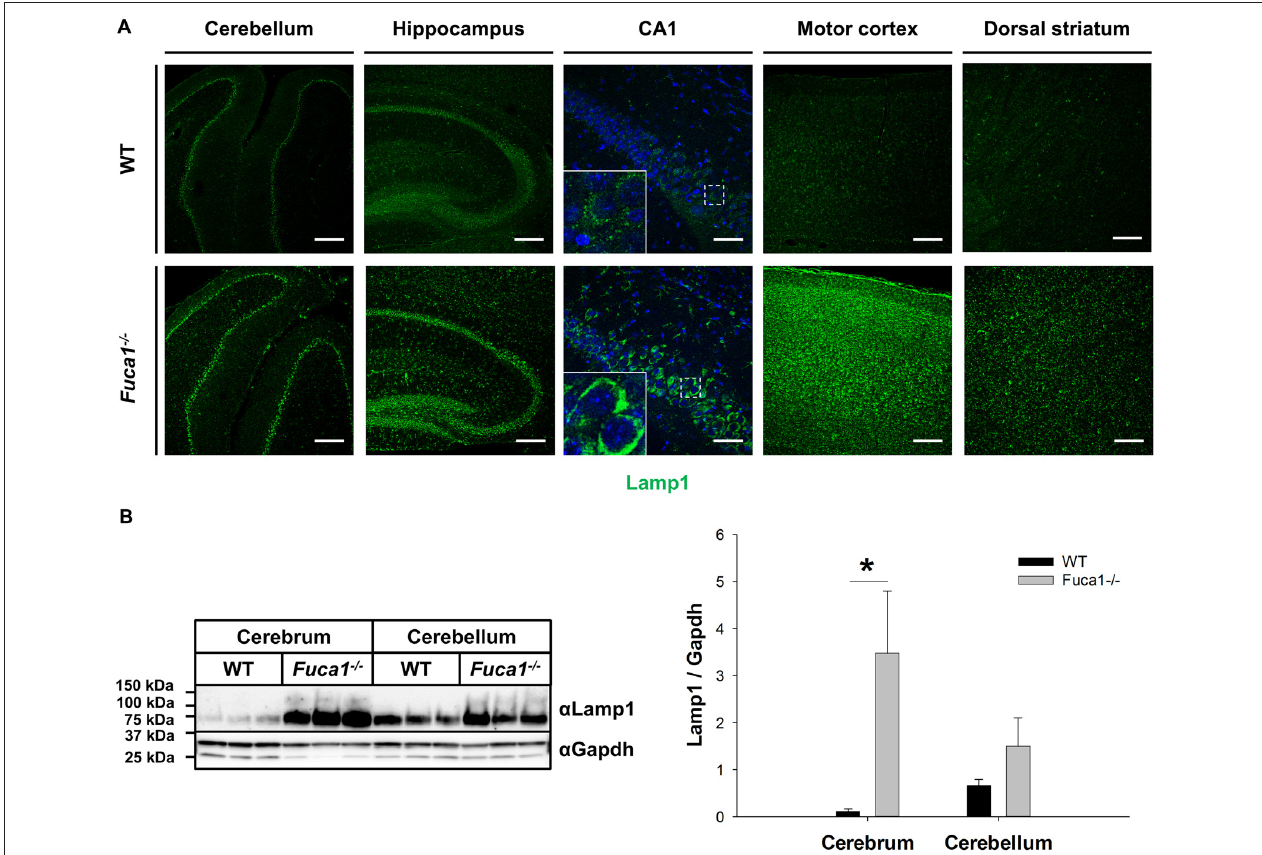
FIGURE 1 | Increased Lamp1 expression in the brain of Fuca1-deficient mice. (A) Immunofluorescence staining of brain sections from 3-month-old mice showed an increase in the lysosome-associated membrane protein 1 (Lamp1) in the cerebellum, hippocampus, motor cortex and striatum of Fuca1-deficient animals. Scale bars = 200 µ m and 50 µ m for magnifications of the hippocampus (CA1). Insets represent further magnifications of the boxed areas, clearly illustrating increased Lamp1 immunoreactivity in Fuca1-deficient mice. Nuclei were stained with DAPI. (B) Immunoblotting of tissue homogenates from 3-month-old mice revealed an increased amount in Lamp1 in the cerebrum but not in the cerebellum of Fuca1-deficient mice (mean ± SD, n = 3). Gapdh was used for normalization. Asterisk indicates significance of difference.